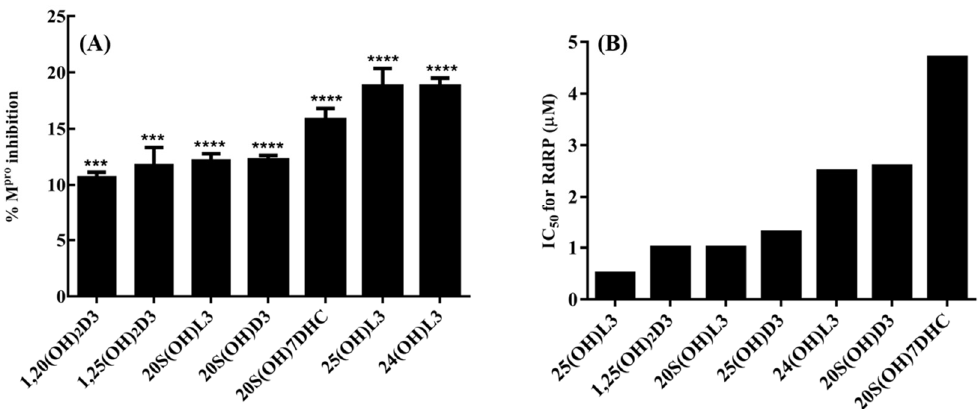
Figure 2. The binding pattern of identified compounds with SARS-CoV-2 M pro . ( A ) structural repre- sentation of the protein in complex with selected sterols and secosteroids. ( B ) selected compounds blocking the binding pocket and making significant interactions with the functionally important residues of SARS-CoV-2 M pro . ( C ) surface representation of conserved substrate-binding pocket of SARS-CoV-2 M pro in complex with selected compounds. ( D ) zoomed view of the substrate-binding pocket of SARS-CoV-2 M pro in complex with selected compounds. Reprinted with permission from the publisher [74].